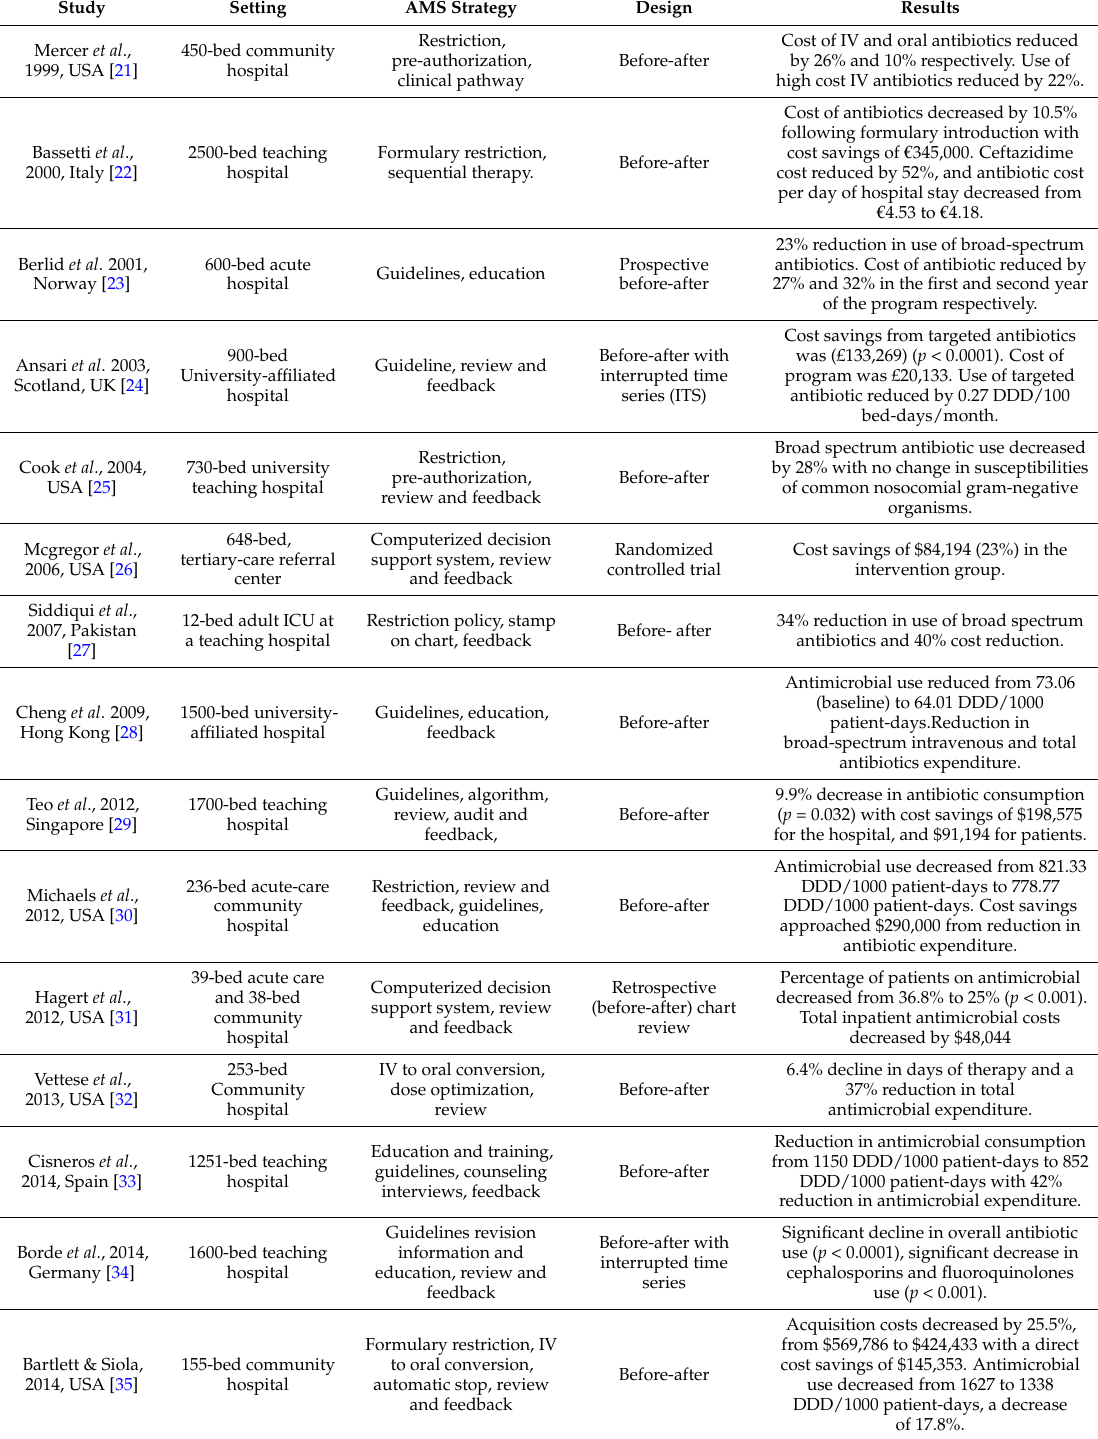
Table 2. Impact of ASP on antimicrobial use and cost of